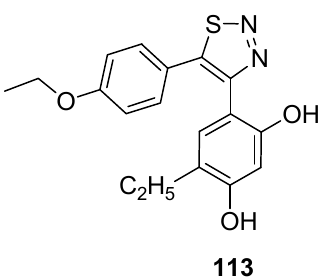
Figure 15. Anticancer activity of 1,2,3-thiadiazole derivative 113 against U2OS and HeLa cell lines.